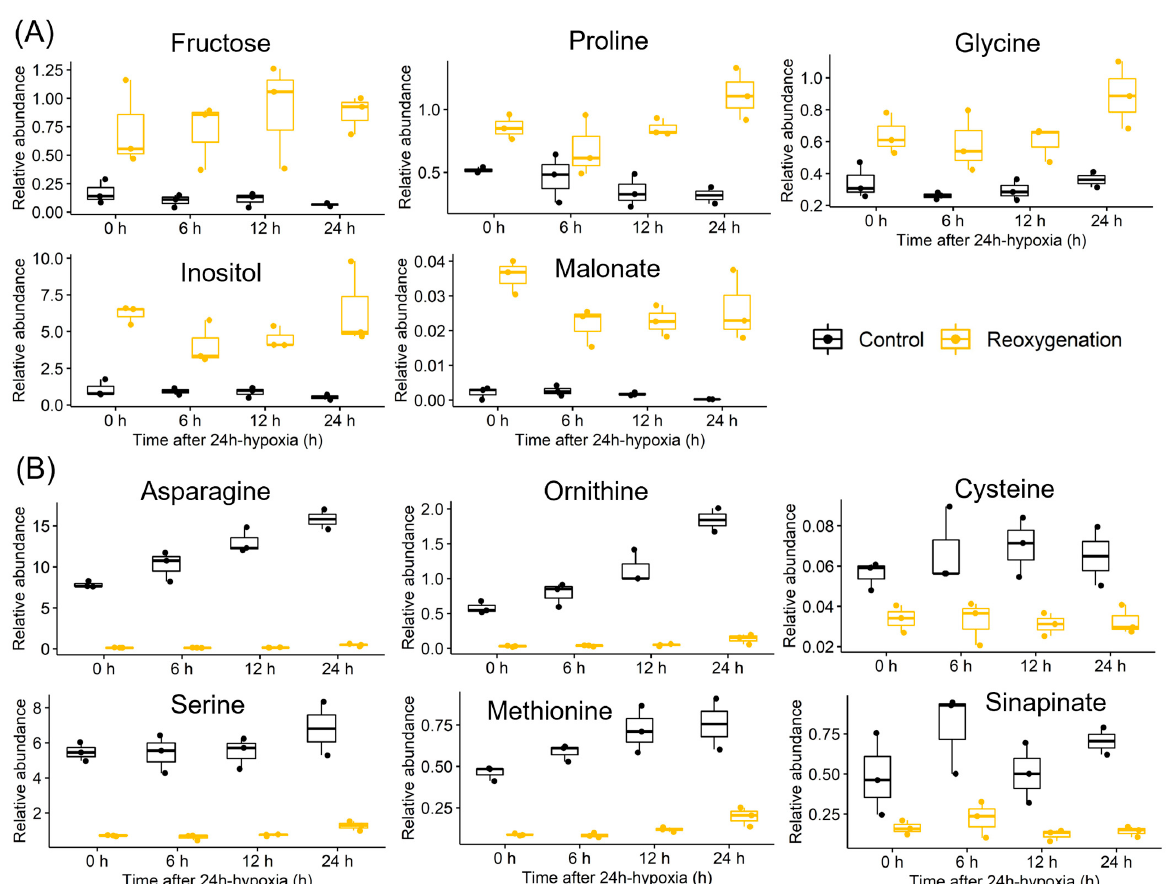
Figure 6. Metabolites kept up-regulated or down-regulated during hypoxia and reoxygenation. ( A ) Fructose, proline, glycine, inositol, and malonate maintained up-regulated during hypoxia and reoxygenation. ( B ) Asparagine, ornithine, cysteine, serine, methionine, and sinapinate kept down- regulated during hypoxia and reoxygenation. Data are presented as box plots (center line at the median, upper bound at 75th percentile, lower bound at 25th percentile) with whiskers extended to the extreme data points ( n = 3).